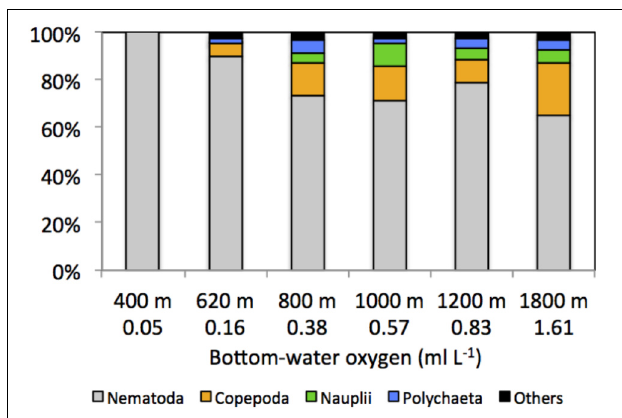
FIGURE 5 | Composition (%) of main meiofaunal taxa along the Costa Rica margin as a function of depth gradient and bottom-water oxygen concentration. Others include kinorhynchs, ostracods, turbellarians, bivalves, gastrotrichs, nemerteans, oligochaetes, isopods, tanaids, priapulids, aplacophorans, amphipods, cnidarians, gastropods, and cumaceans.